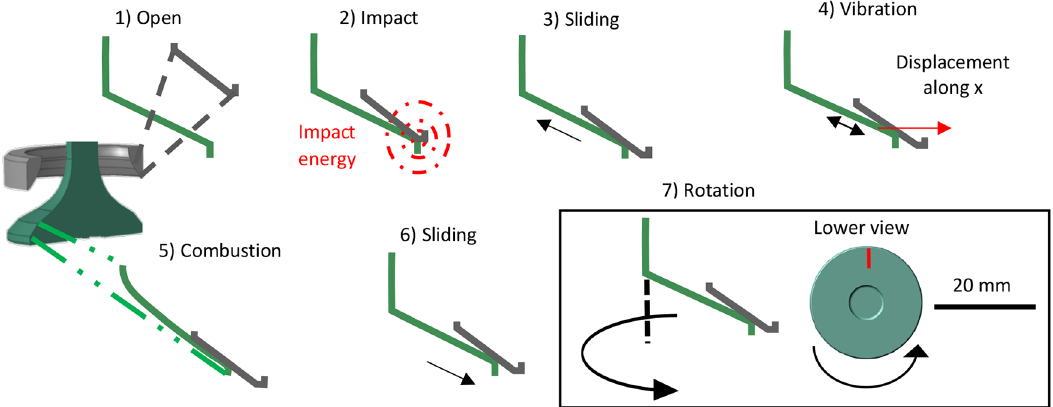
Fig. 8. Valve-seat contact dynamic imposed by the valve train.